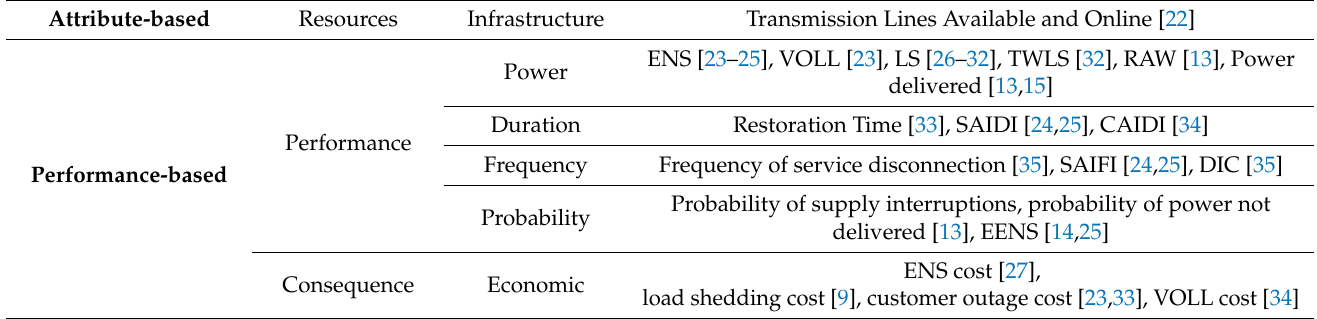
Table 1. Most common attribute-based and performance-based metrics used in the literature. The following abbreviations are used in the table: Customer Average Interruption Duration Index (CAIDI), System Interruption per customer (DIC), Energy Not Served (ENS), Expected Energy Not Supplied (EENS), Load shedding (LS), Risk Achievement Worth (RAW), System Average Interruption Duration Index (SAIDI), System Average Interruption Frequency Index (SAIFI), Total Weighted Load Shedding (TWLS), Value of Lost Load